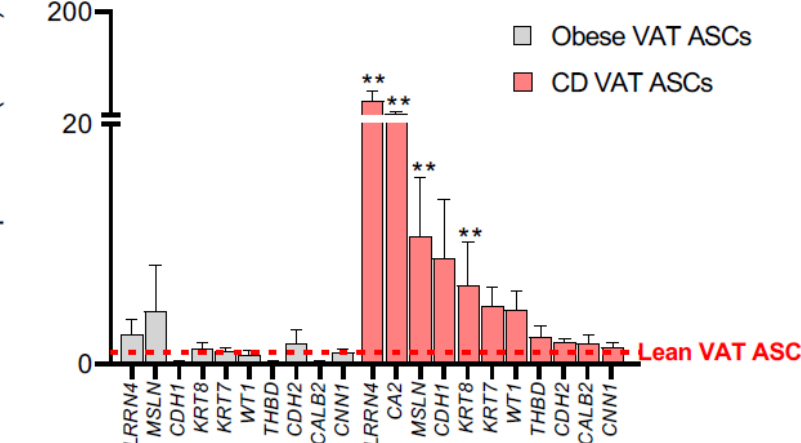
Figure 4. Mesothelial marker expression in VAT-derived ASCs from patients with Crohn’s disease is upregulated with respect to equivalent lean progenitors. qPCR analysis of mesothelial marker expression in obese and Crohn’s disease VAT-derived ASCs versus equivalent lean-derived cells. Mean lean VAT-derived ASC values were normalized to 1, and are represented as a red dotted line. Abbreviations: ASCs, adipose-derived stem cells; CD, Crohn’s disease; ob, obese; THBD , thrombomodulin; VAT, visceral adipose tissue. Data are expressed as mean ± SEM; ** p <0.01 (Mann-Whitney U test with Benjamin-Hochberg adjustment).